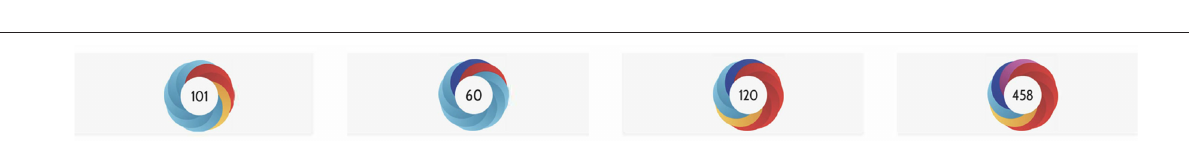
FIGURE 7 | Survey statistics for the iconic form of SP. (A) Accuracy scores per task. (B) Mean completion times per task.